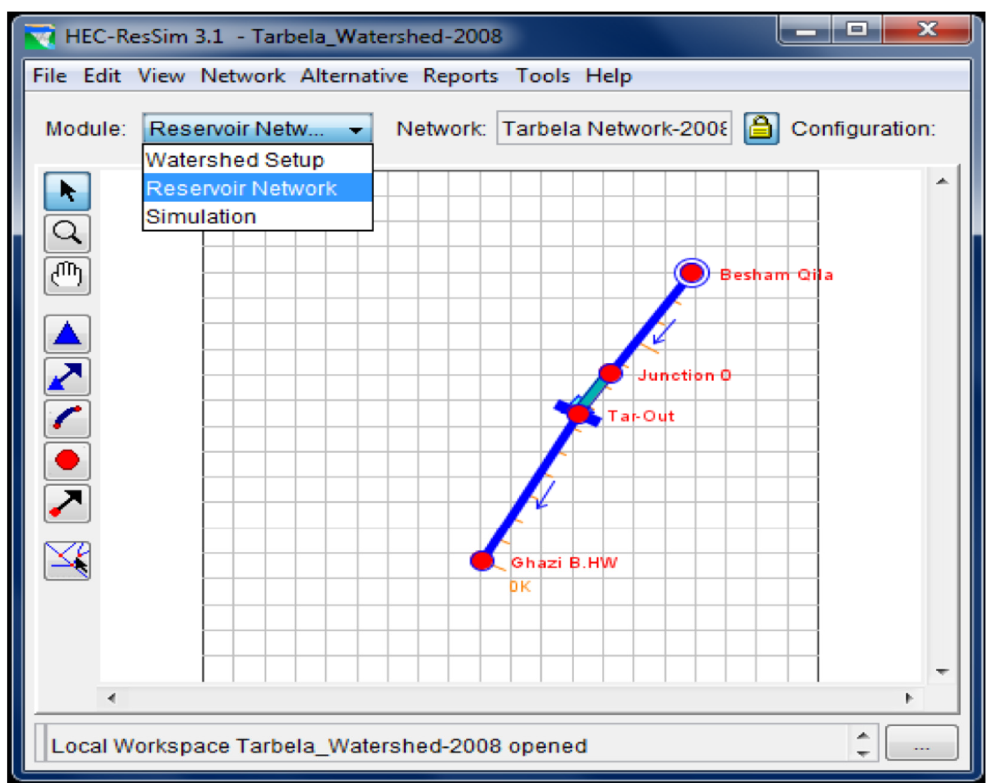
Figure 16. Schematic of Tarbela Reservoir Network. (Blue line shows river reach while yellow part shows Tarbela reservoir).